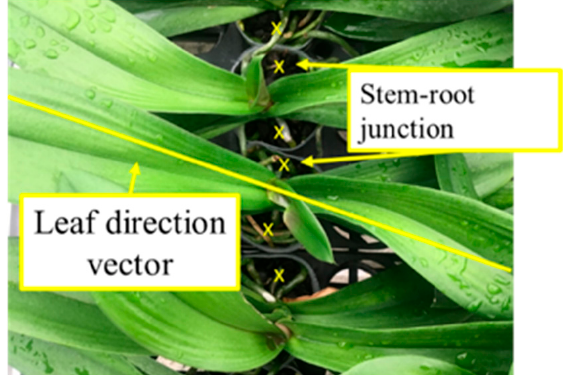
Figure 7. Direction vector of the leaf and target watering point to be modified (stem-root junction).